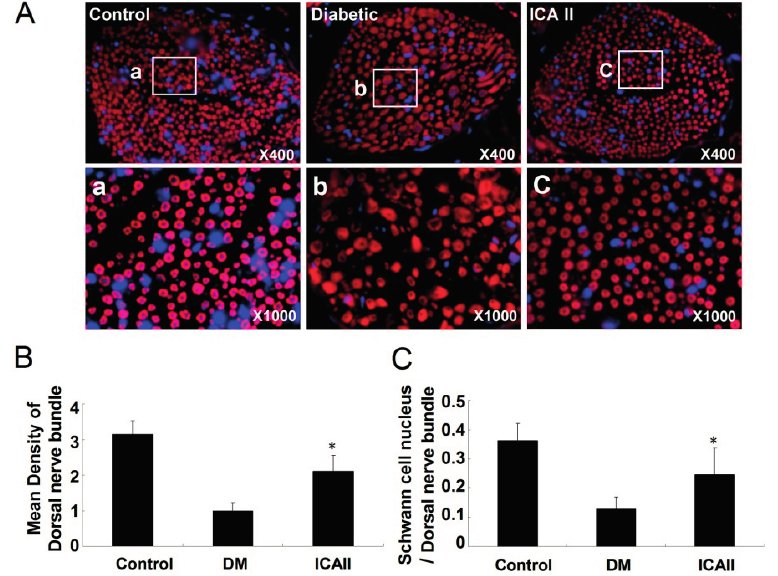
Figure 2. Semiquantitative analyses of dorsal nerve bundle and Schwann cell nucleus in normal, diabetic and ICA II rat corpus cavernosum groups (a/b/c showed the typical area of the three groups respectively). ( A ) Immunofluorescence stained with antibody to Neurofilament (NF); ( B ) The mean density of dorsal nerve bundle by immunofluorescence staining; ( C ) The ratio of Schwann cell nucleus to dorsal nerve bundle. Each bar depicts the mean values (±standard deviation) from N = 10 animals per group. * p < 0.01 in the ICA II-treated group compared with the DM placebo group.